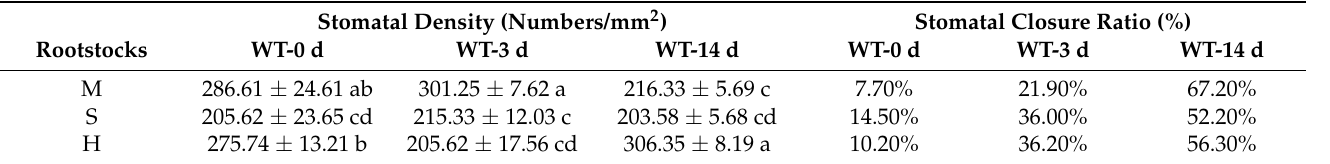
Table 1. Comparison of leaf stomatal density and stomatal closure ratio of different peach rootstocks under waterlogging stress.